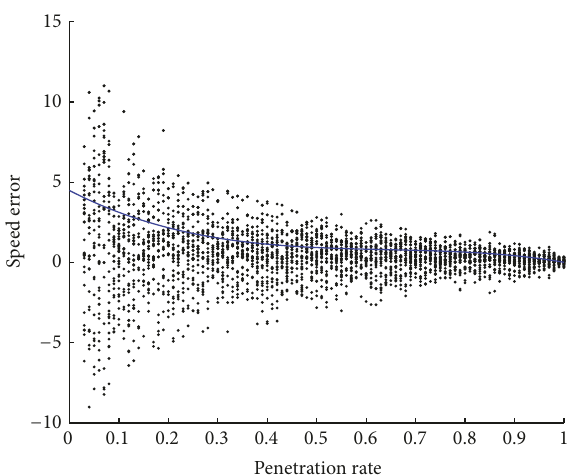
Figure 5: Estimation of percentual speed errors for the average speed at a road section with speed limit 80 km/h, moderate traffic flow, and a length of 400 m, based on FCD samples with different penetration rates. The solid curve represents the average absolute percentage